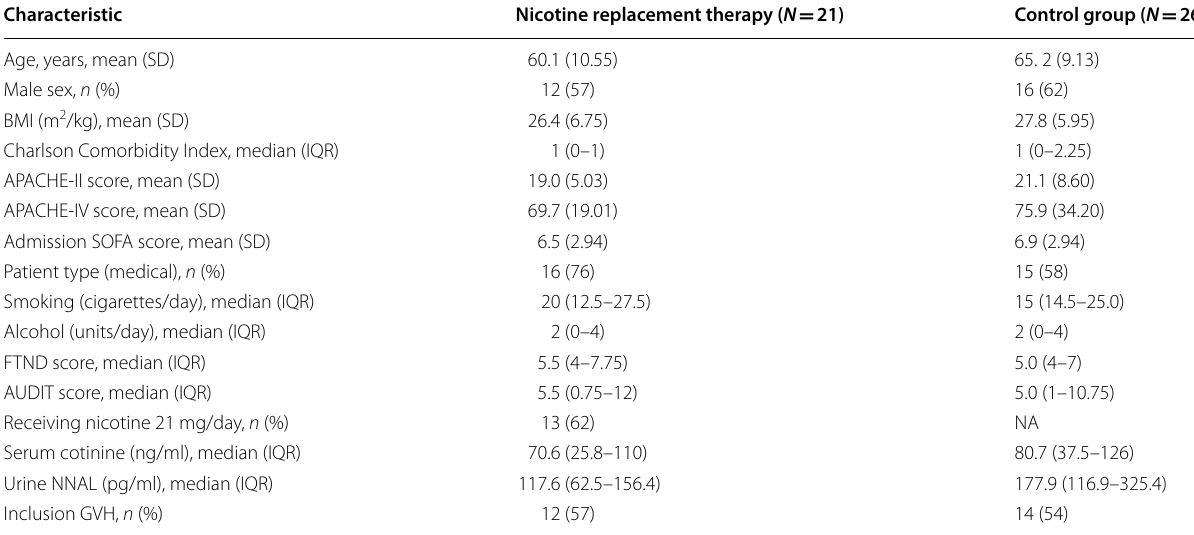
Table 1 Baseline characteristics of the patients